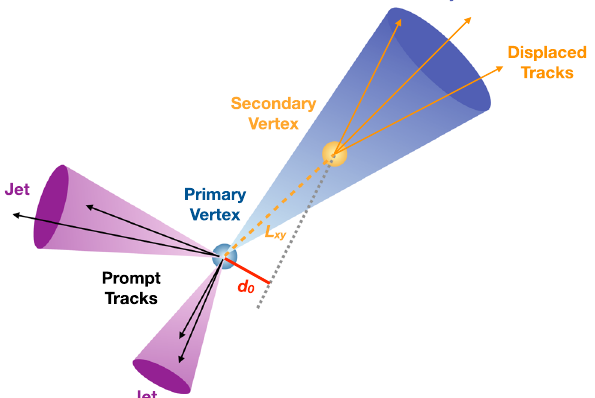
Fig. 1 A schematic diagram of an interaction producing two light- flavour jets and one b -jet, shown in the transverse plane. The lifetime of b -hadronscorrespondstoatransversedecaylength, L xy (typicallyafew mm), and produces displaced tracks originating from a secondary ver- tex. The distance of closest approach of a displaced track to the primary vertex is defined as the transverse impact parameter, d 0 , and typically is large for tracks originating from the decay of b -hadrons. Conversely, jets initiated by light-flavour quarks or gluons will not exhibit these features and typically contain mostly prompt tracks originating from the primary vertex